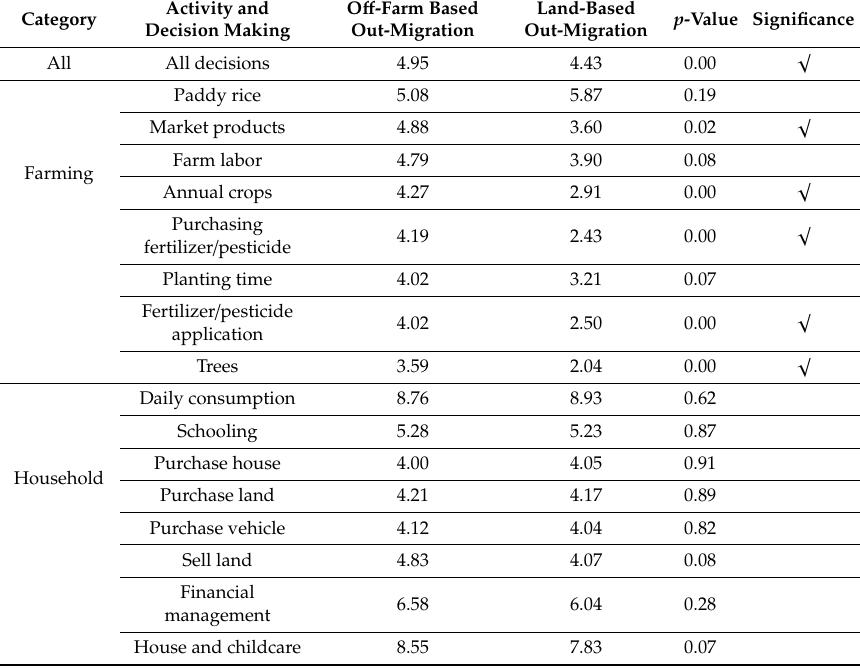
Table 5. Women’s workload and power related to decision making based on the type of migration, West